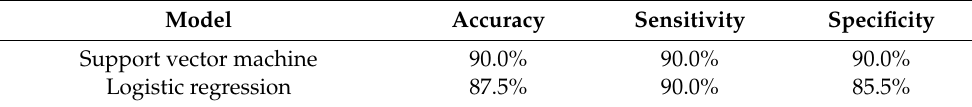
Table 5. Support vector machine and logistic regression scores when trained on the seven paintings dataset using AIDEAL eye movement and DGI features